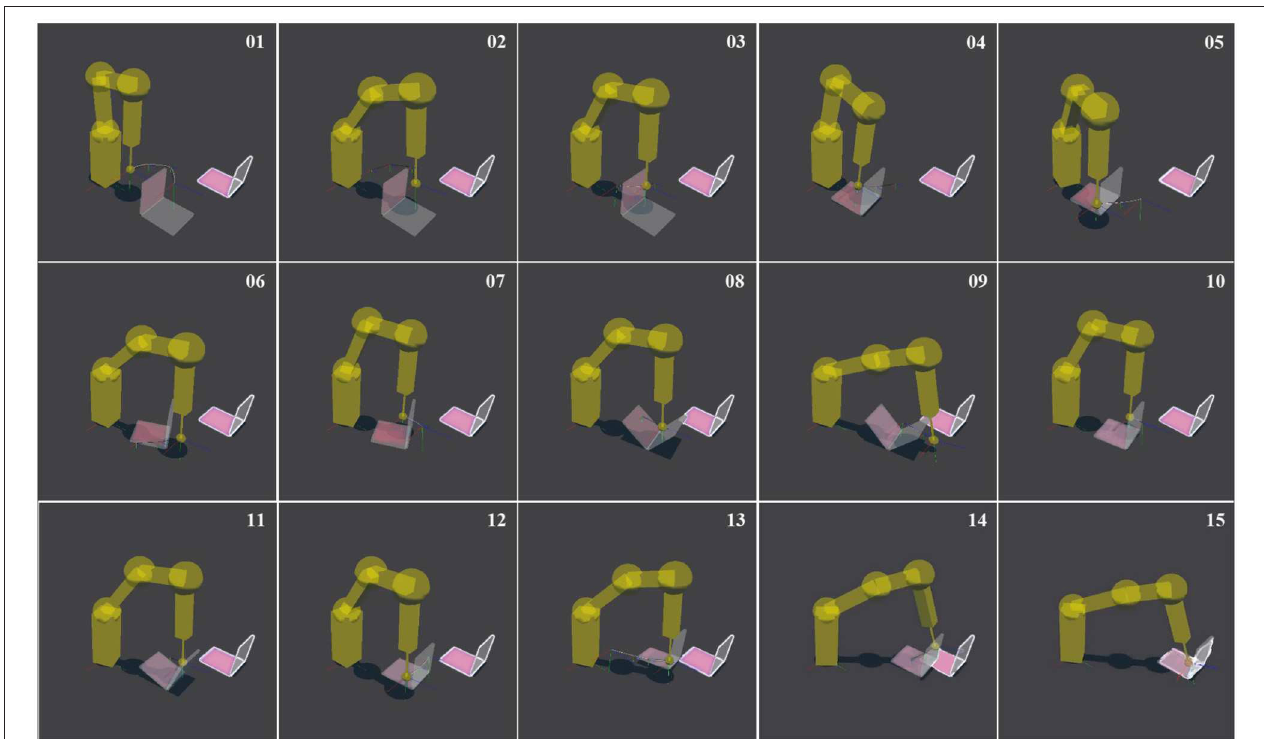
FIGURE 6 | Simulation of a Katana robot arm equipped with a spherical finger that plans a sequence of pushes to move an L-shaped object, called polyflap (Sloman, 2006) to a goal state. The plan is created by using a physics engine (PhysX) to predict the outcome of a push operation. Image 01 shows the initial pose. The wire-framed L-shaped polyflap is a “phantom” to indicate the desired goal state. The goal pose is translated from the initial pose by 28 cm and rotated by 90 ◦ . Image 02 shows the collision-free trajectory to bring the end effector to the start pose of the first push. Images 01–04 show the first push which makes the polyflap tip over. Images 05–09 show a series of pushes which culminate in the polyflap resting in an unstable equilibrium pose along its folded edge. Images 12 and 13 show a sideways push. Images 14 and 15 show the final frontal push which aligns the polyflap with the target configuration. Courtesy of Zito et al.